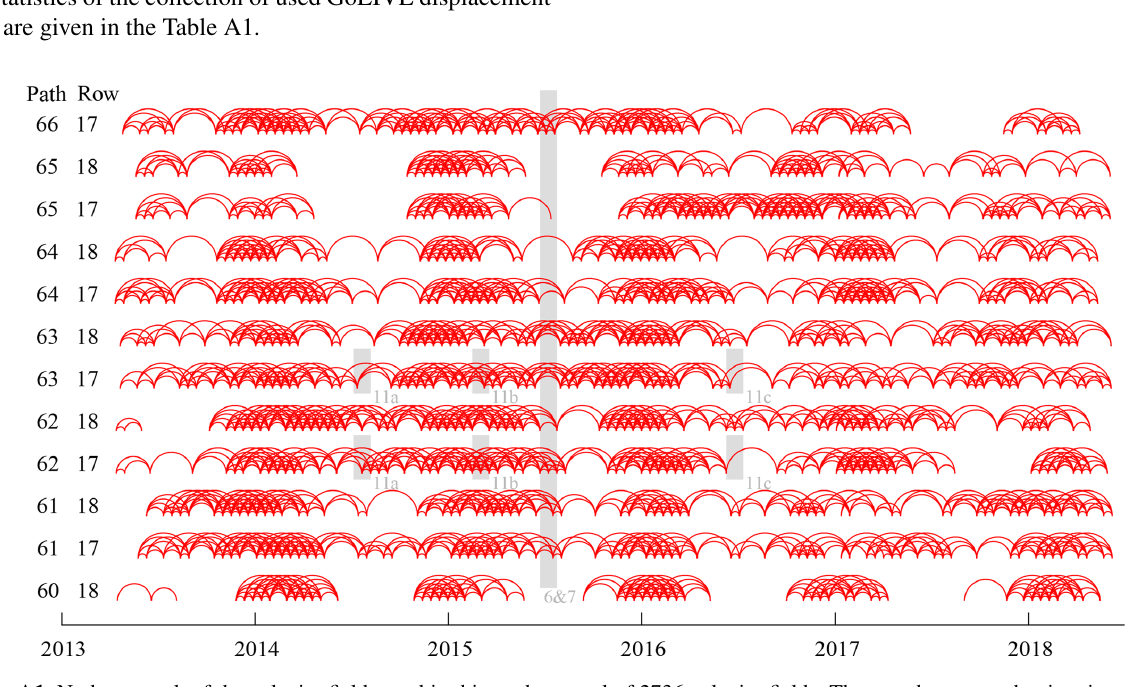
Figure A1. Node network of the velocity fields used in this study, a total of 2736 velocity fields. The gray bars span the time interval used for the generation of the different velocity products used in the figures in the main text. The specific numbering is given by their annotation, which is also in gray.